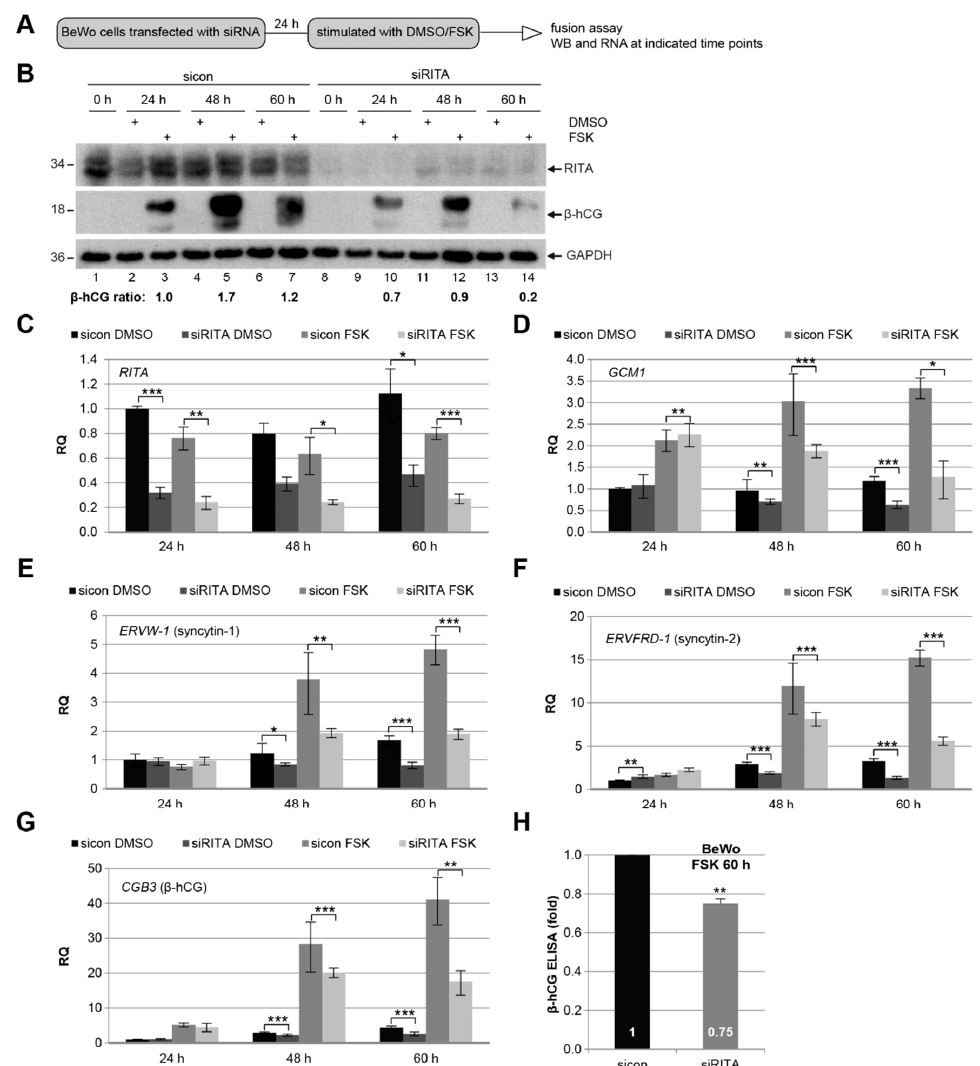
Figure 5. Depletion of RITA leads to a reduction of fusion related genes in BeWo cells. ( A ) Working schedule for fusion assay. BeWo cells were transfected with control siRNA (sicon) or siRNA targeting RITA (siRITA) and then stimulated with forskolin (FSK) to induce cell fusion or vehicle control dimethyl sulfoxide (DMSO) up to 60 h. ( B ) Western blot analysis of treated cells with antibodies against RITA and chorionic gonadotropin subunit beta 3 ( β -hCG). GAPDH was used as loading control. The ratios of β -hCG/GAPDH are shown. ( C – G ) Gene analysis. The mRNA levels of RITA ( C ) and fusion-related glial cells missing transcription factor 1 ( GCM1 ) ( D ), syncytin-1 ( ERVW-1 ) ( E ), syncytin-2 ( ERVFRD-1 ) ( F ) and β -hCG ( CBG3 ) ( G ) are shown. The results are presented as relative quantification (RQ) with minimum and maximum range. Student’s t -test, * p < 0.05, ** p < 0.01, *** p < 0.001. ( H ) Level of secreted β -hCG. The supernatants of BeWo cells treated with FSK for 60 h were collected for the measurement of secreted β -hCG. The data from three independent experiments are presented as mean ± SEM. Student’s t -test, ** p < 0.01.